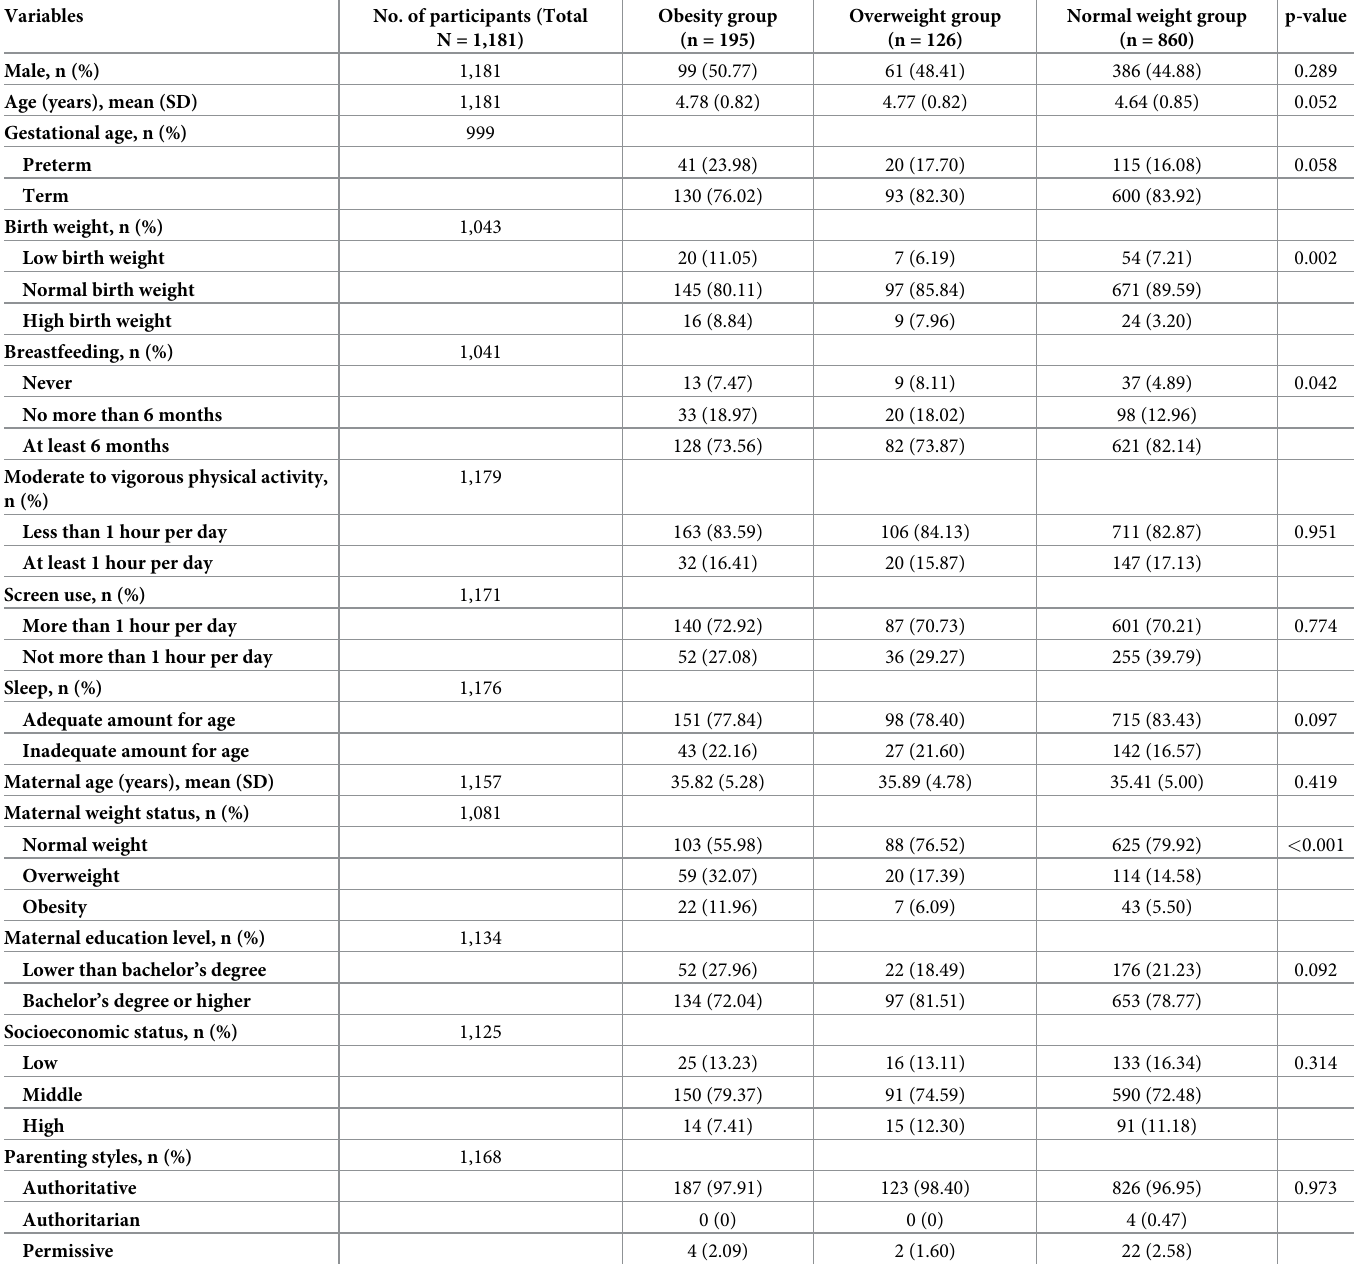
Table 2. Possible variables contributing to weight excess categorized by weight